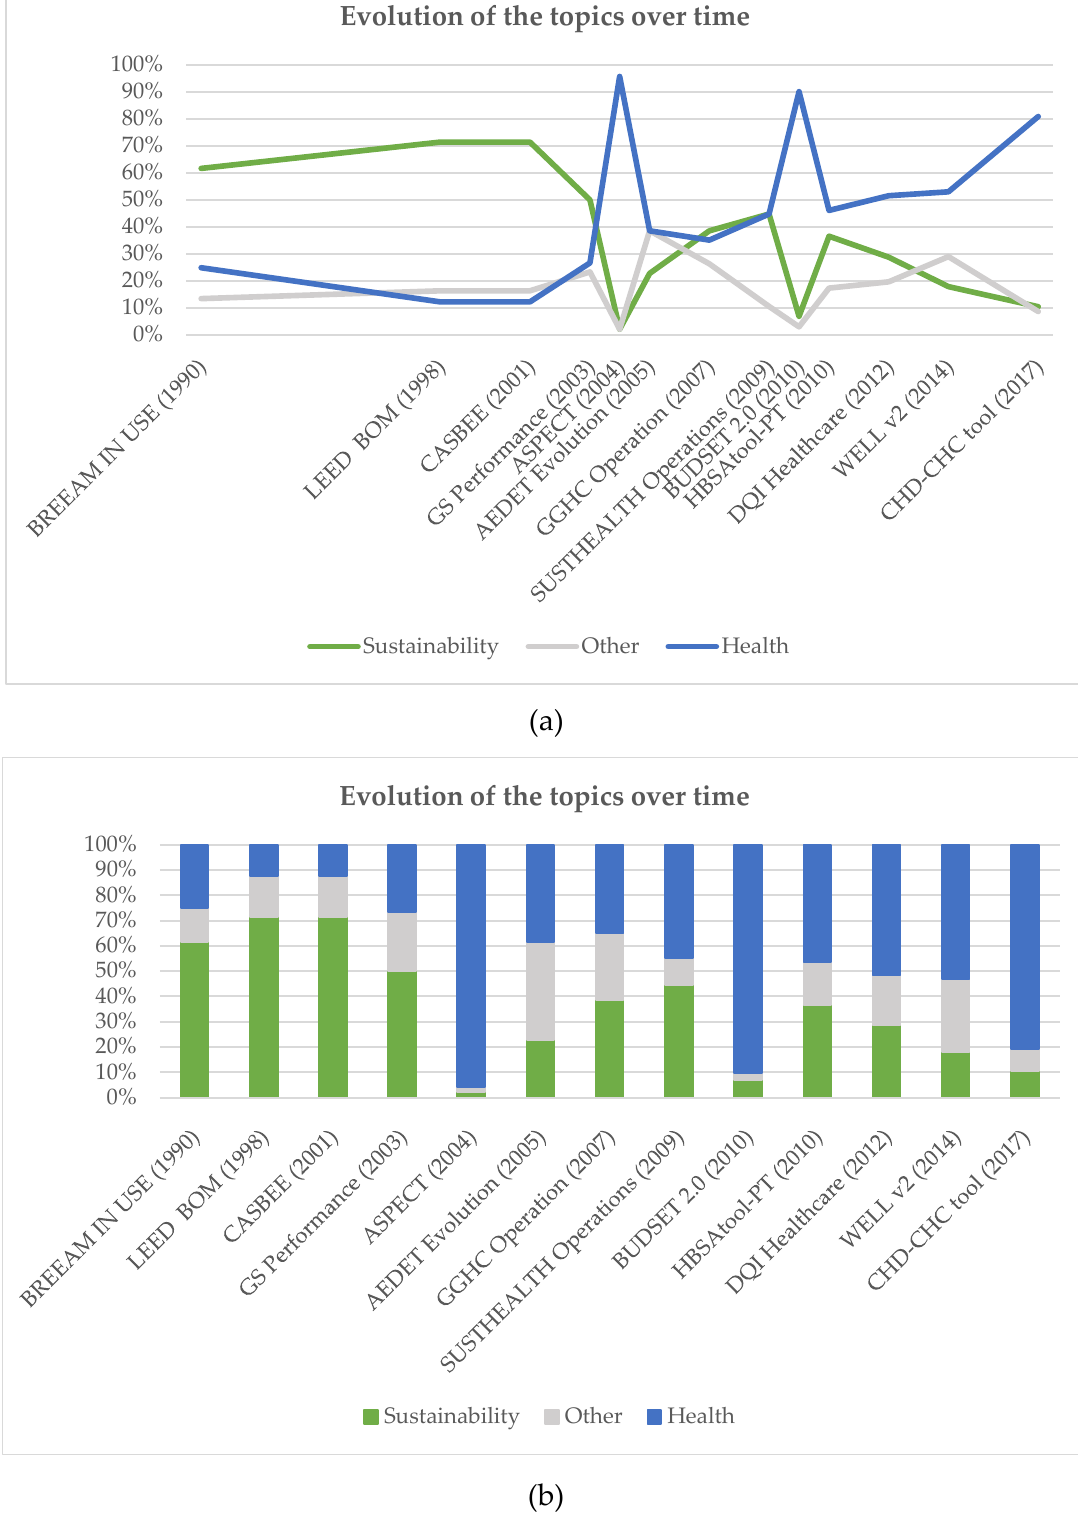
Figure 6. Evolution of the topics Sustainability, Health, and Others over time, from 1990 to 2017 ( a ) and distribution of the topics in the different instruments, listed in chronological order ( b ).